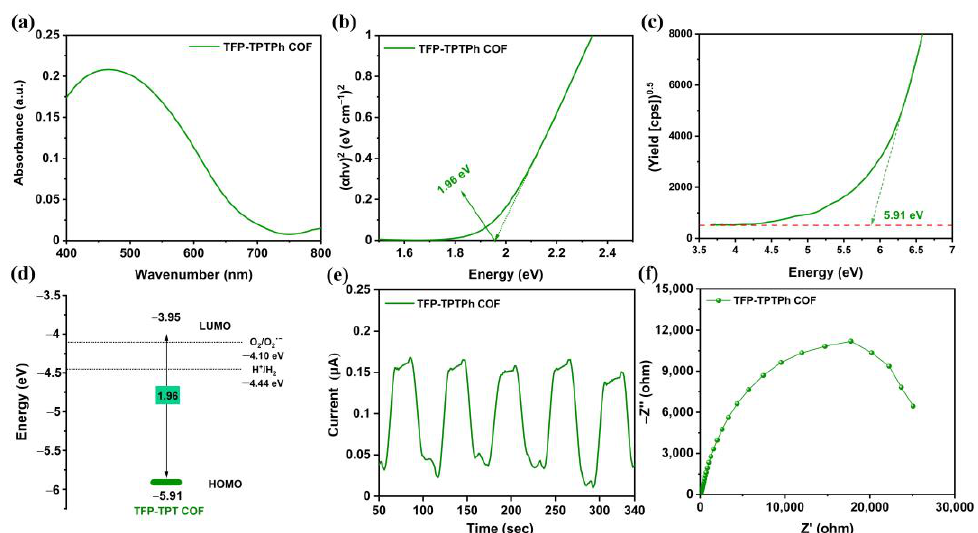
Figure 3. ( a ) UV–Vis DRS spectrum of TFP-TPTPh COF. ( b ) Tauc plot of TFP-TPTPh COF. ( c ) Photoelectron spectrum of TFP-TPTPh COF. ( d ) Electronic band level of TFP-TPTPh COF. ( e ) Periodic on/off photocurrent response of TFP-TPTPh COF. ( f ) EIS spectrum of TFP-TPTPh COF. All measurements were carried out at 25 °C.